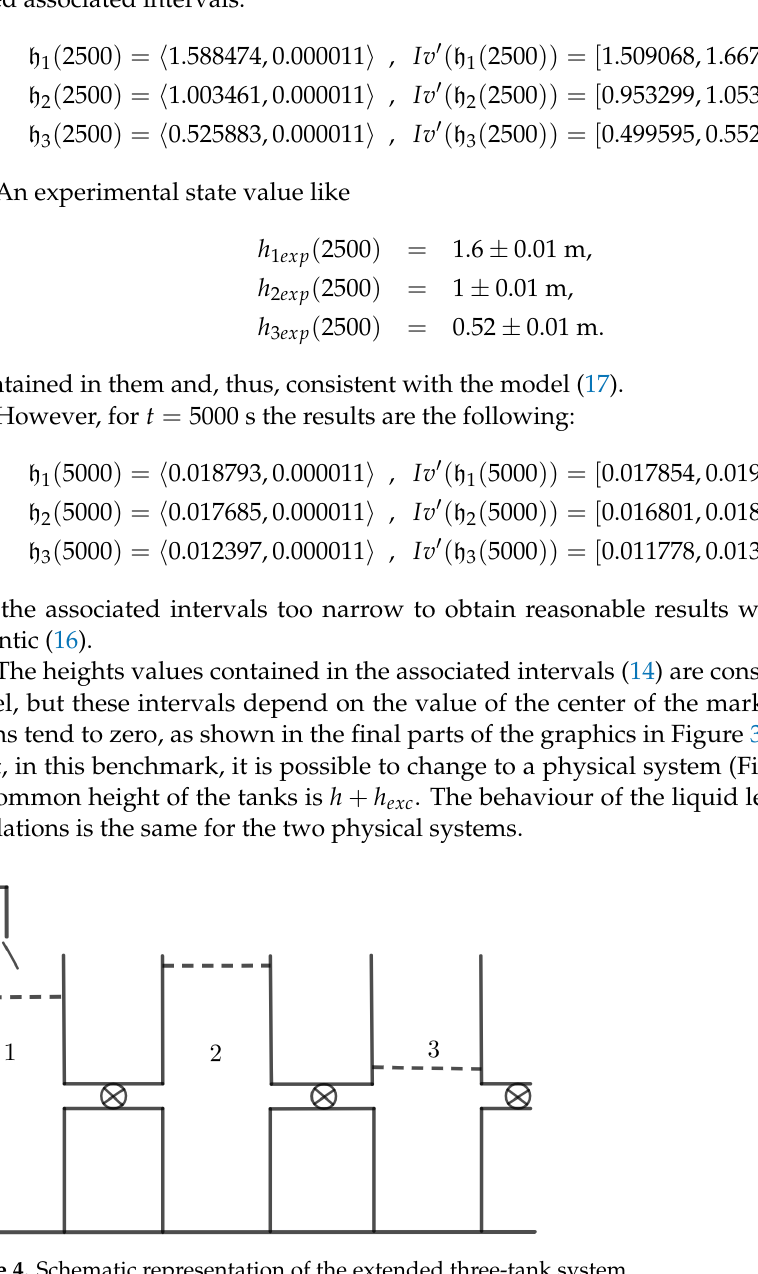
Figure 5. Extended three-tank system. Simulation results for the three state variables using real numbers.The dark bands are only apparent. They are the accumulation of the 1000 little vertical segments which represent the intervals associated to the resulting marks in the 1000 simulation points